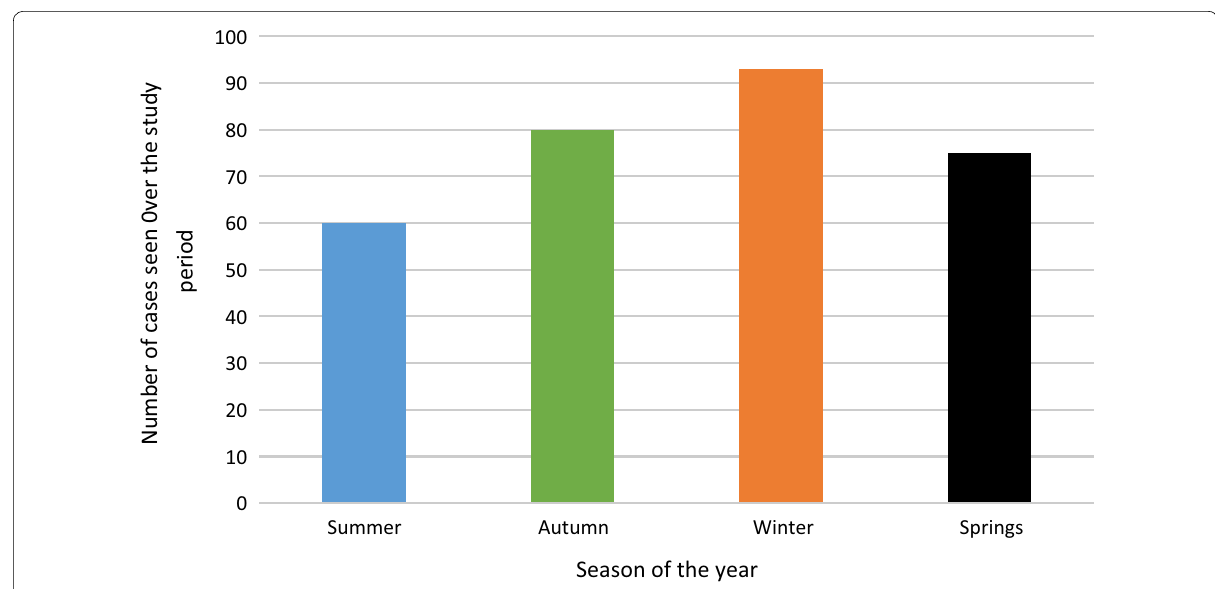
Fig. 2 Number of testicular torsion cases seen per season over the study period